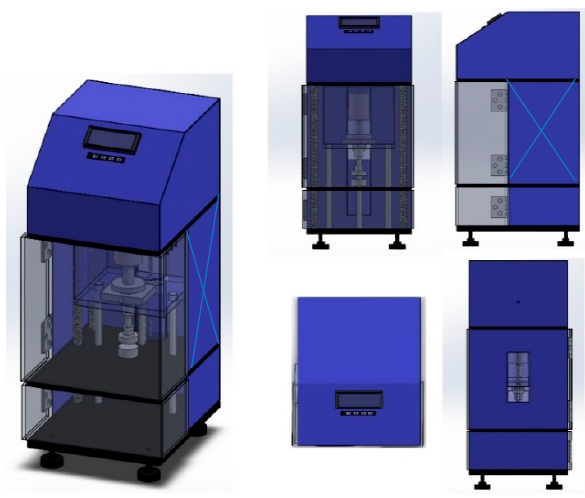
Figure 10. Final rheometer design.